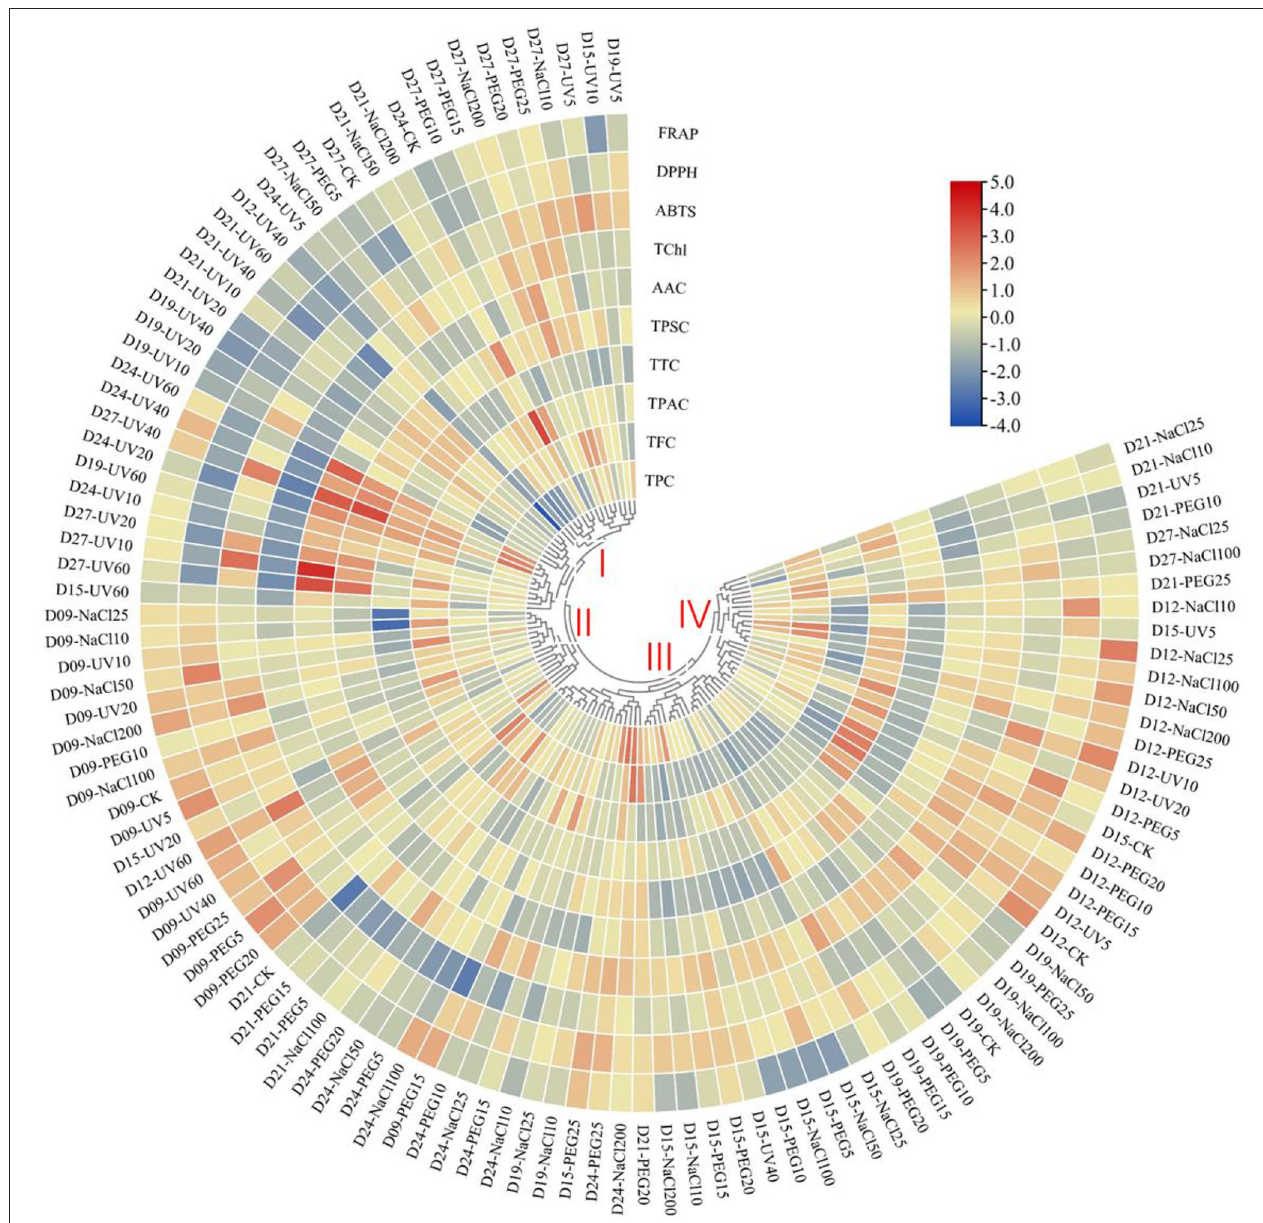
FIGURE 3 | Heatmap hierarchical clustering analysis (HHCA) of the various abiotic treatments on different seedling ages of wheatgrass. Each value of the seven main functional phytochemicals and three antioxidant activity indices of abiotic treatments are visualized in a column, and each of the treatments is represented by a row. The abundance of each phytochemical content is represented by a bar with unique color. Red means upregulation, and blue means downregulation. The heatmap is constructed by TBtools software. Distance methods are using Pearson’s